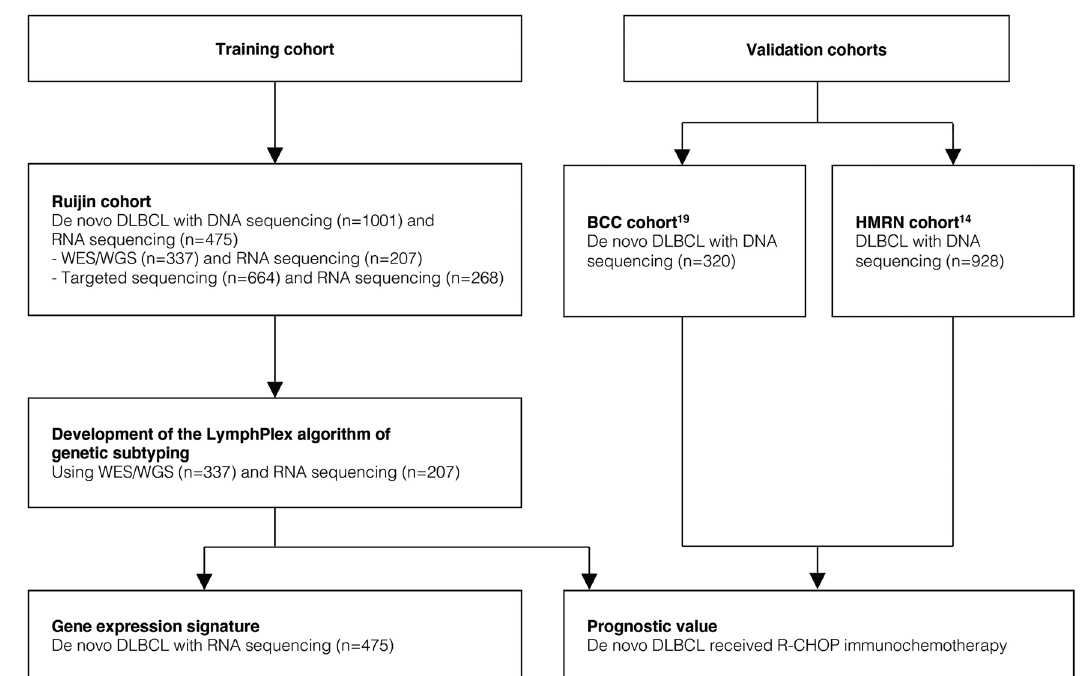
Fig. 6 Flow chart of the study. DLBCL diffuse large B-cell lymphoma, WES whole-exome sequencing, WGS whole-genome sequencing, R-CHOP rituximab, cyclophosphamide, doxorubicin, vincristine, and